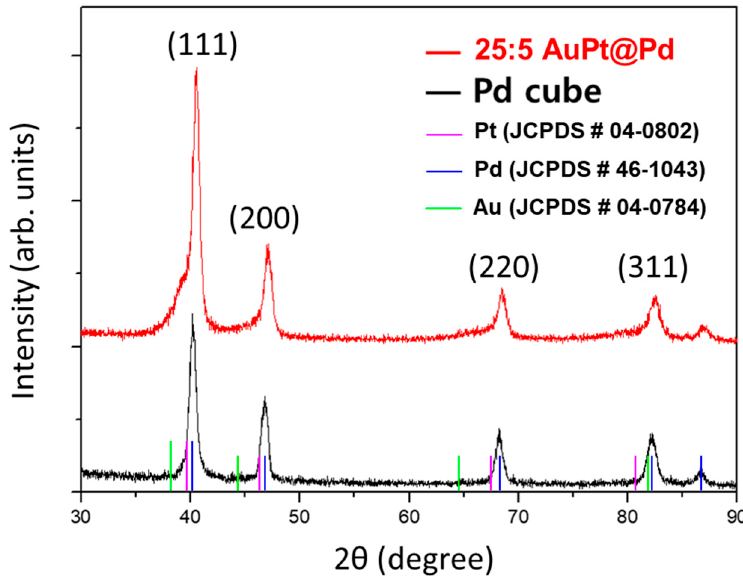
Figure 4. X-ray di ff raction (XRD) data of Pd cubes and AuPt@Pd Figure 4. X-ray diffraction (XRD) data of Pd cubes and AuPt@Pd 25:5.